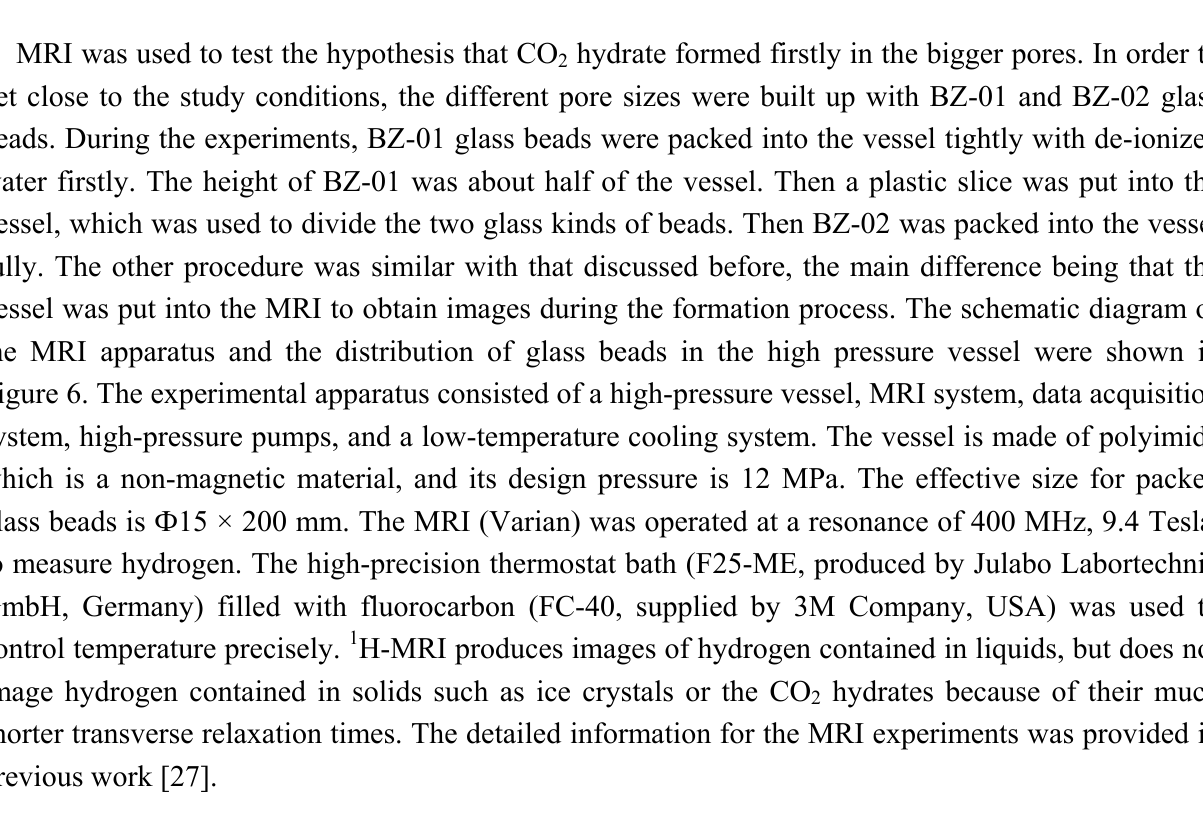
Figure 6. Schematic diagram of the MRI apparatus and the distribution of glass beads in the high pressure